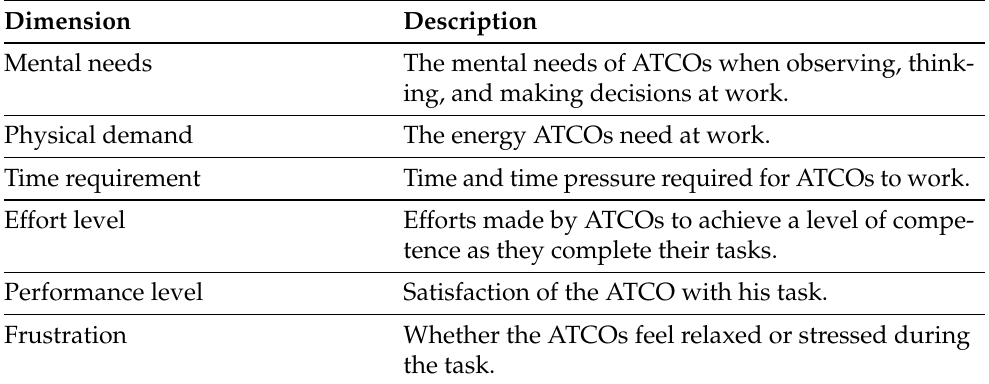
Table 5. Dimensions of the NASA-TLX